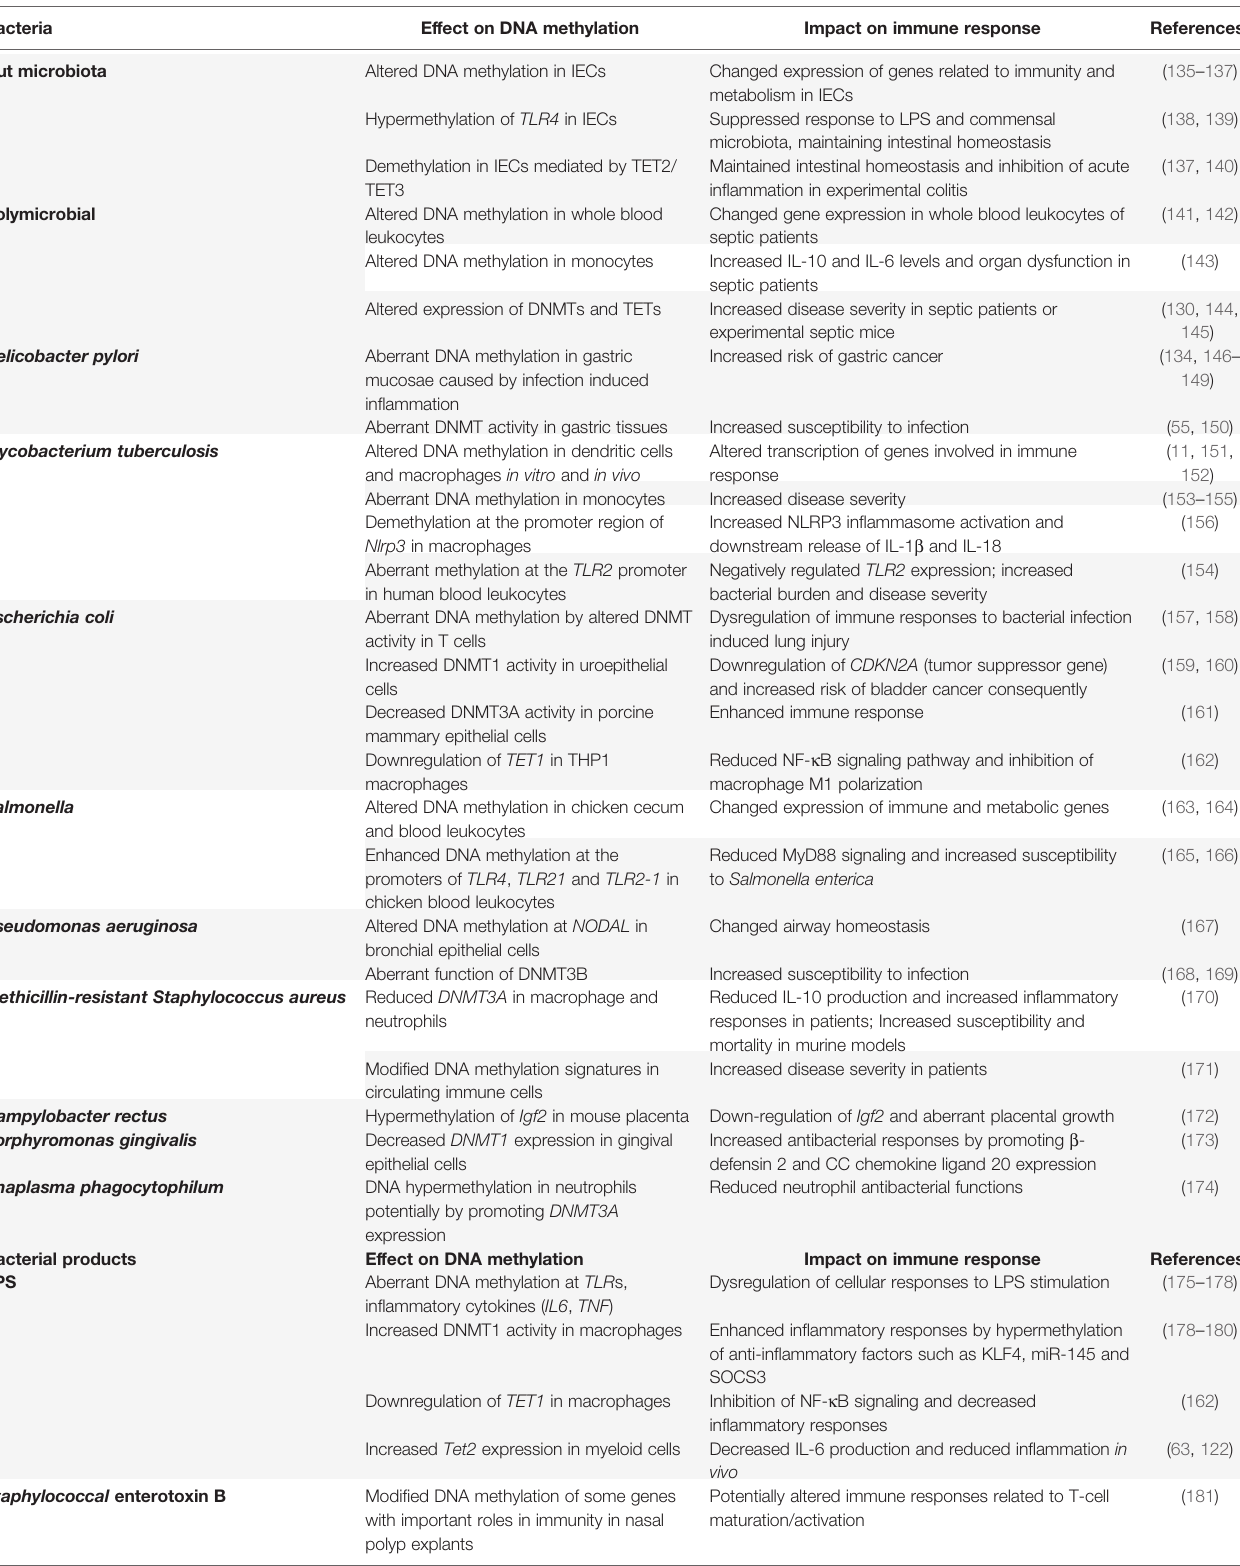
TABLE 1 | Modi fi cation of DNA methylation induced by bacteria and its effects on immune